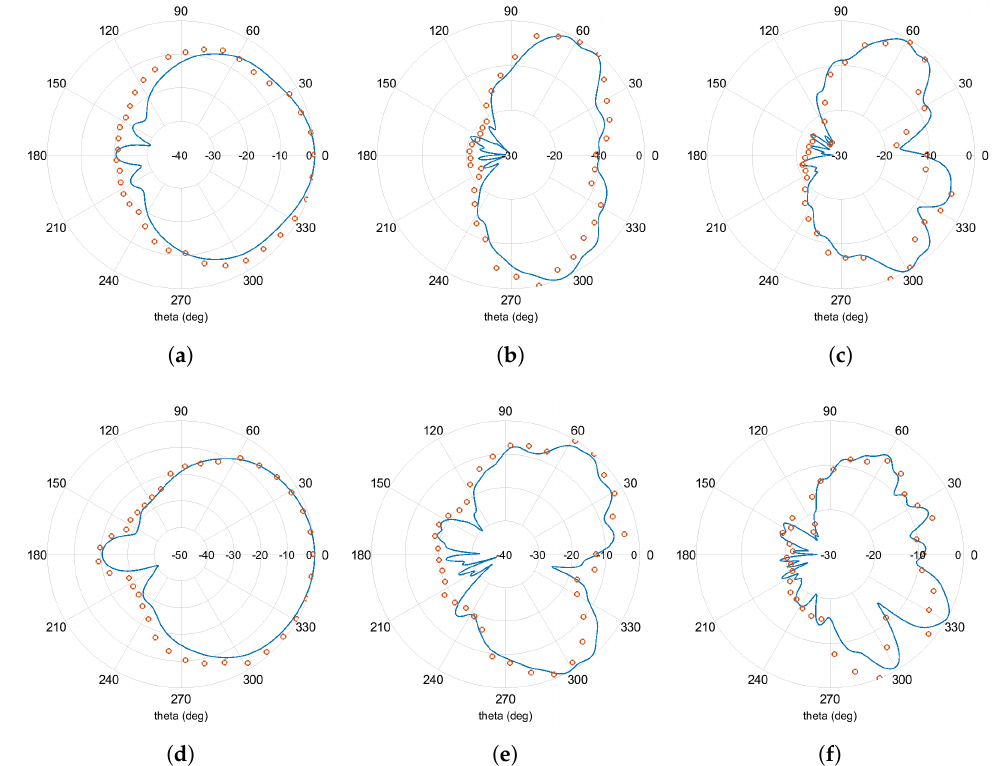
Figure 7. Normalized radiation pattern plots in the main planes (XZ, YZ) of the modified E-shaped patch antenna (Computed results are displayed in blue solid lines, whereas measured results are displayed in orange circular markers. Radial axis is expressed in dB.) ( a ) freq = 866.4 MHz (XZ plane), ( b ) freq = 1841 MHz (XZ plane), ( c ) freq = 1957 MHz (XZ plane), ( d ) freq = 866.4 MHz (YZ plane), ( e ) freq = 1841 MHz (YZ plane), and ( f ) freq = 1957 MHz (YZ